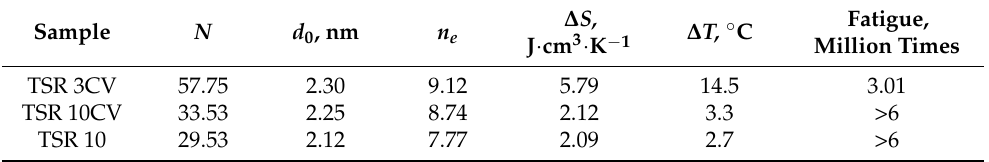
Table 5. Temperature rise, fatigue life and related network structure parameters of NR